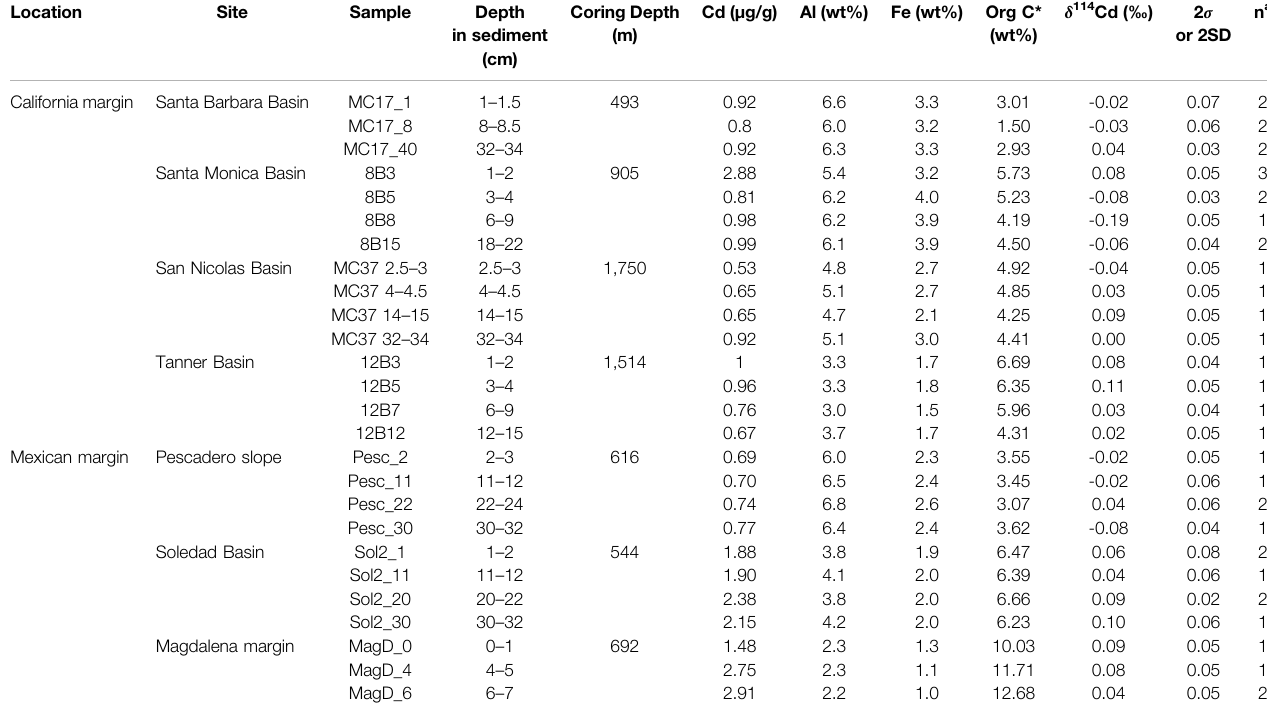
TABLE 2 | Summary of results, including bulk sediment Cd isotope compositions and Cd, Al and Fe concentrations. Location